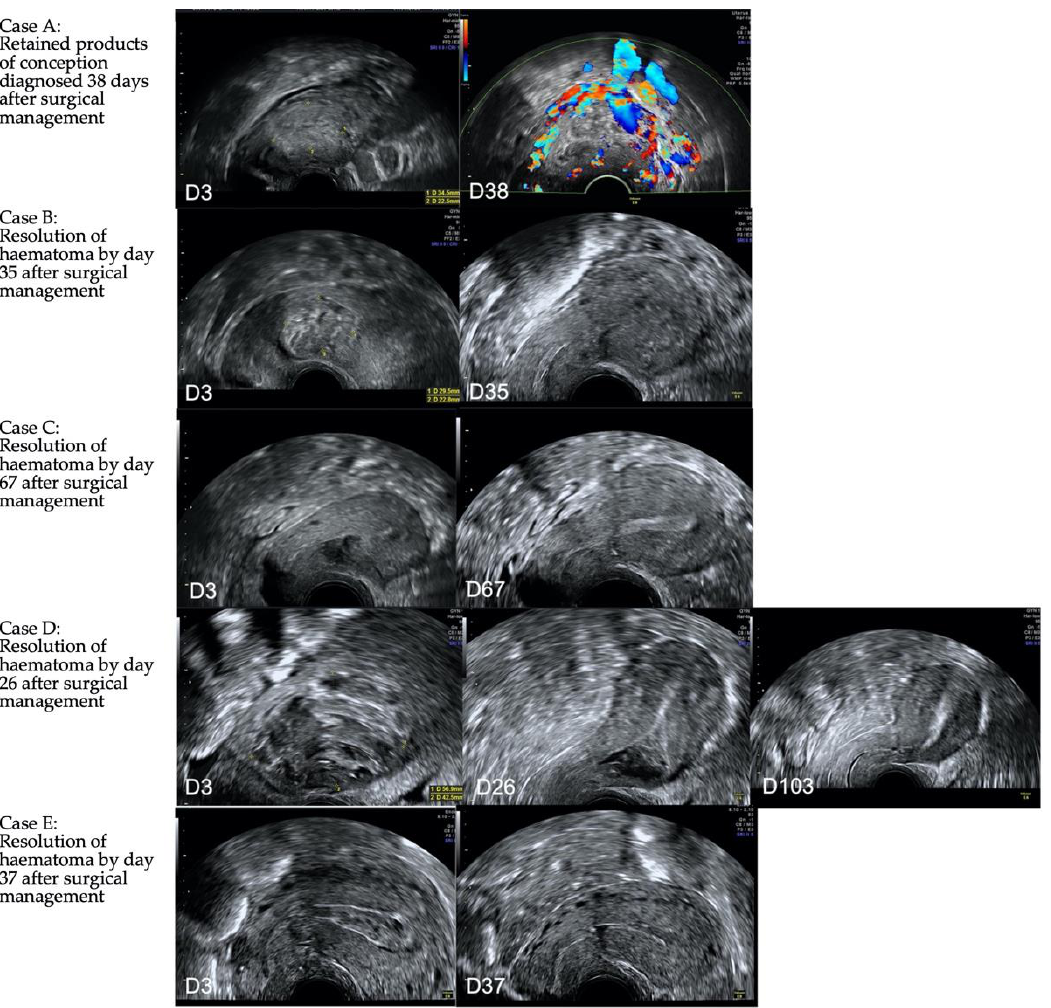
Figure 5. Longitudinal ultrasound images of five cases (case A – E) managed surgically with cerclage and balloon. The initial image was obtained on day 3 (D3) at the time of cerclage removal, and subsequent images are obtained between day 26 and 103 post surgical management. In 4/5 the haematoma present on day 3 resolves, whereas in one (A), retained products of conception is diagnosed at day 38 post surgery.